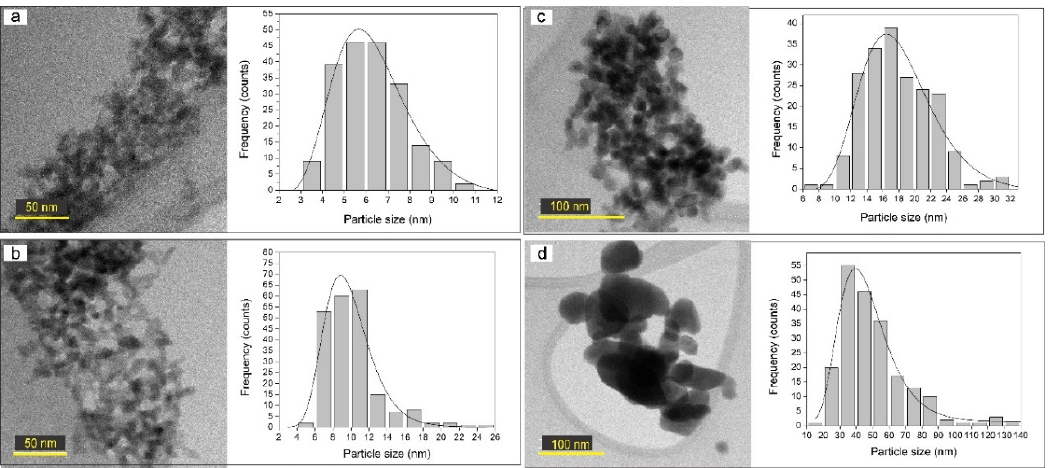
Figure 6. TEM images and particle size distribution of sample s10m; ( a ) as-synthesized, annealed at: ( b ) 100 °C, ( c ) 300 °C, and ( d ) 500 °C.